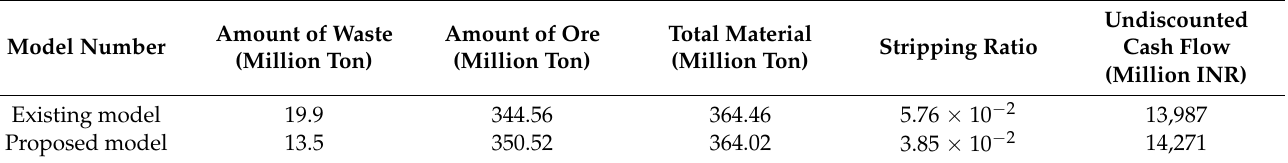
Table 5. Amount of waste, ore, total materials, and stripping ratio of an ultimate pit of the deposit using the proposed model (Model 2) and existing model